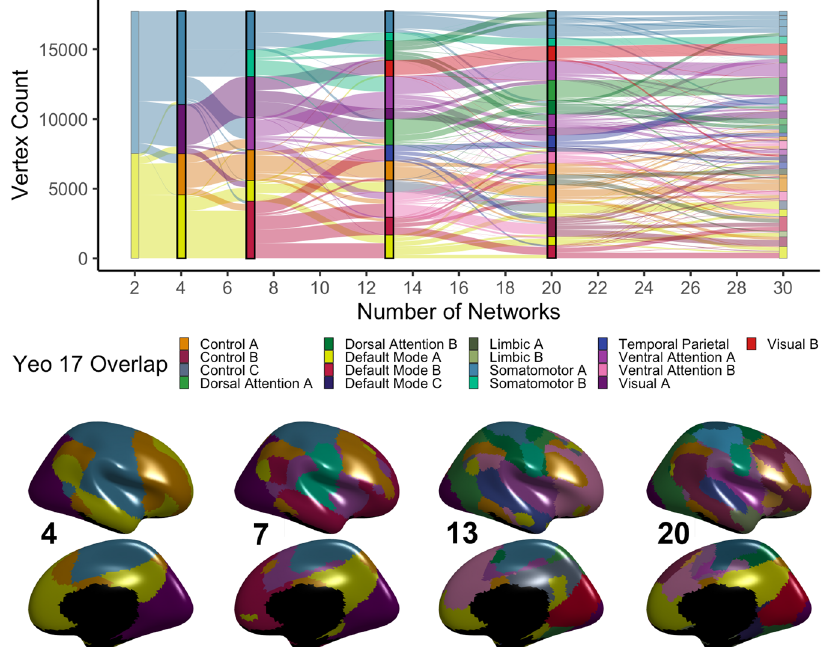
Fig. 1 Group-consensus functional networks at multiple scales. We used regularized non-negative matrix factorization (see Supplementary Fig. 1) to derive personalized functional networks at 29 scales (2 – 30 networks). Tracking network membership of each vertex across scales reveals a nested structure where fi ner-grained networks gradually emerge from coarse networks (top). Scales 4, 7, 13, and 20 are chosen for visualization; see bottom panel for cortical projections. Colors re fl ect each network ’ s predominant overlap with a canonical atlas of 17 functional networks 84